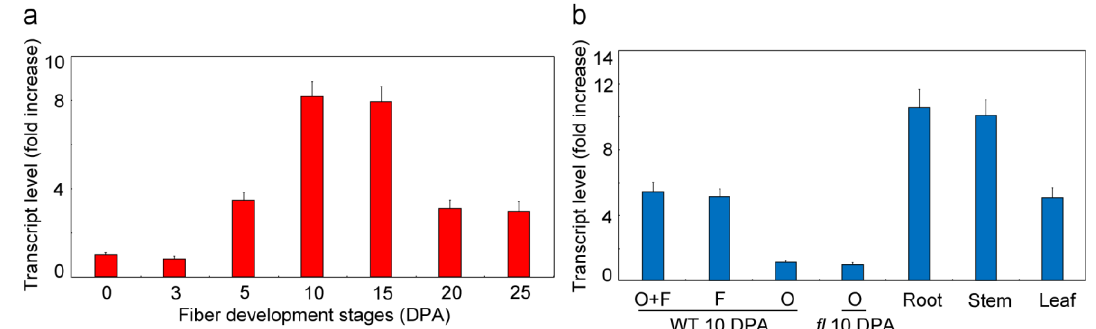
Figure 3. Transcript expression analysis of GhVTC1 during the fiber development stages. ( a ) GhVTC1 is preferentially expressed in fast elongating fibers. The wild-type (WT) materials of 0 DPA ovules and presented 3 – 25 DPA ovules associated with fibers were collected for the detection of qRT-PCR analysis. The qRT-PCR data of 0 DPA ovules was artificially set to 1. ( b ) Tissue-specific expression analysis of GhVTC1 . The presented materials at 10 DPA, including WT ovules (O), fibers (F), and ovules-associated fibers (O + F), and fuzzless-lintless mutant ovules, roots, stems, and leaves were collected for qRT-PCR detection. The qRT-PCR data of 10-DPA fl mutant ovules was artificially set to